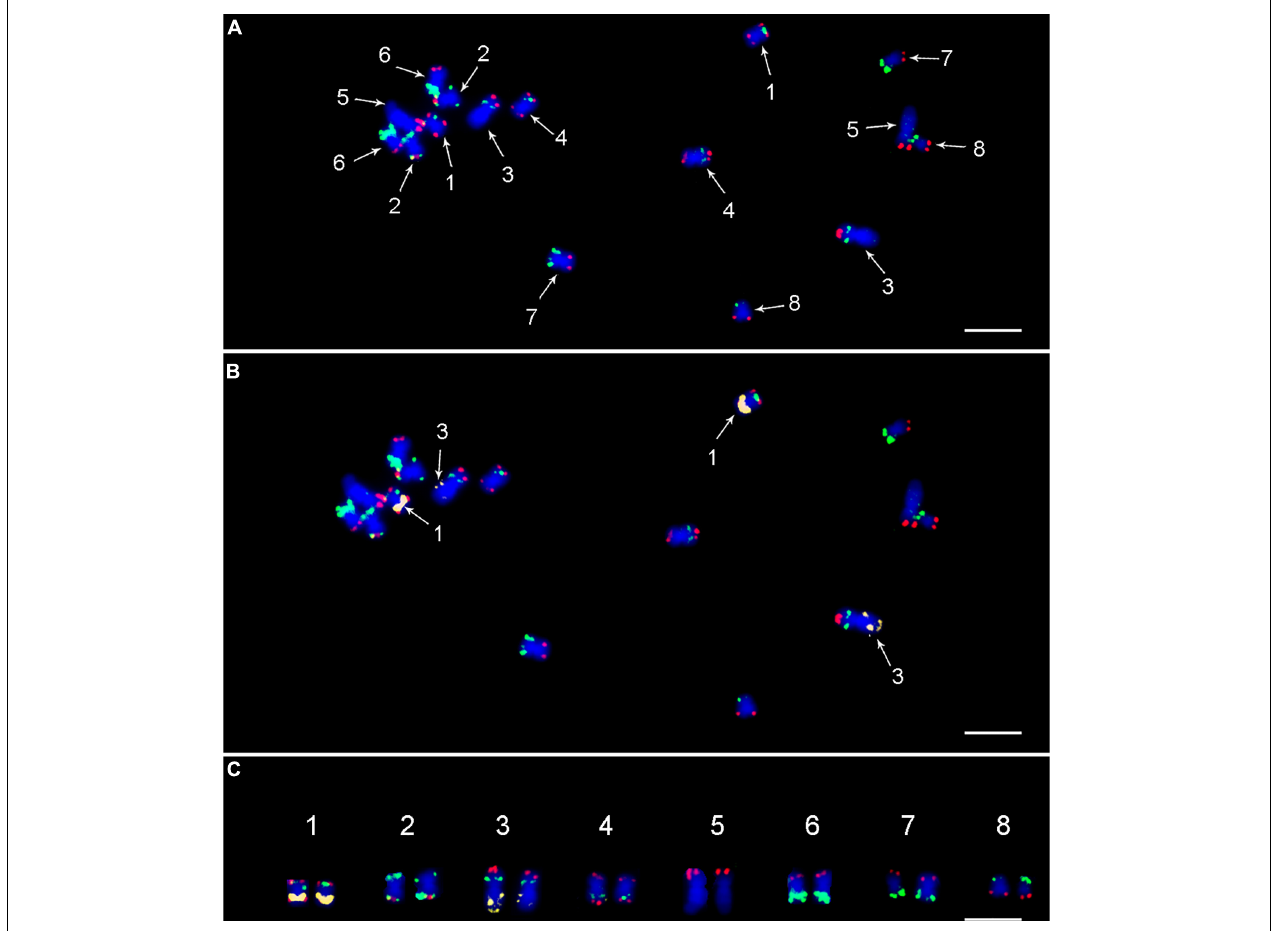
FIGURE 2 | FISH on mitotic metaphase plate of Cicer arietinum CDC Frontier (kabuli type) using (A) painting probes CAF-OP1 (green) and CAF-OP2 (red); (B) combination of painting probes and 5S rDNA probe (yellow), which was used to unambiguously distinguish chromosomes 1 and 3. (C) Molecular karyotype of CDC Frontier genotype (kabuli type). Chromosomes were counterstained with DAPI (blue). Bar = 3 µ